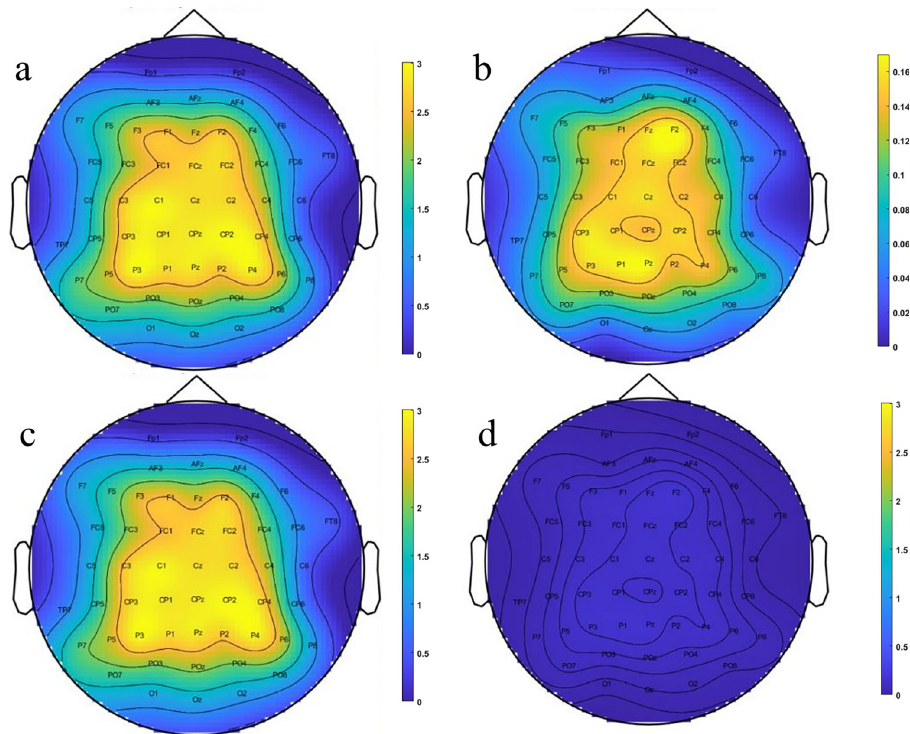
Fig 9. The topoplot of coupling values obtained with sparse analysis. a, b) The topoplot for the task-related (a) and non-task (b) were shown based on their specific maximum thresholds. c, d) Results after correcting the threshold for better comparison of coupling values for task-related (c) and non-task (d) channels; Both topoplots are presented based on the same threshold (i.e., the maximum threshold of both task-related and non-task values in the first